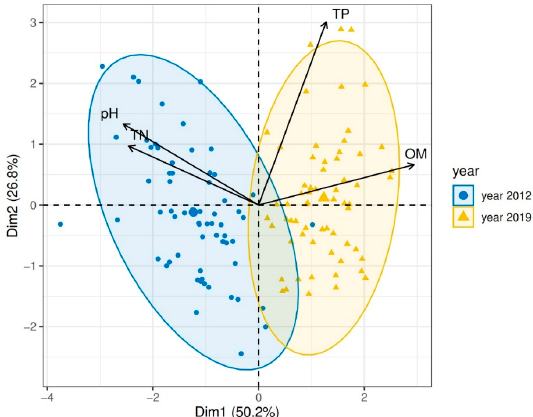
Figure 2. Canonical correspondence analysis (CCA) between dominant species richness (red species abbreviation) and soil nutrients (blue nutrient abbreviation) in the secondary tropical evergreen monsoon forest in 2012 ( A ) and 2019 ( B ). OM, organic matter; TN, total nitrogen; TP, total phosphorus.